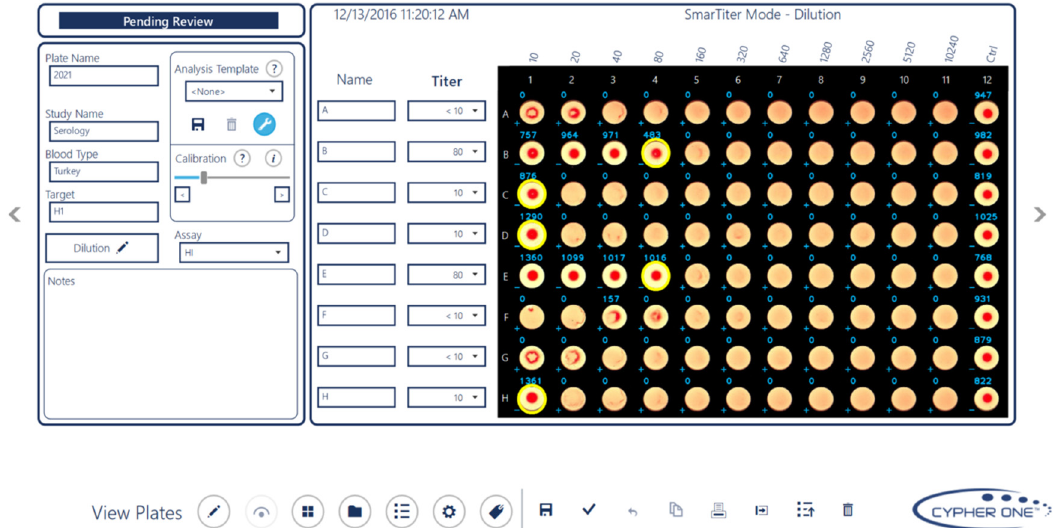
Fig 2. Screen shot of Cypher One user interface. ExampleHAI plate image within a screen shot of the Cypher One software application.High resolutiondigital images were captured and titer values determined using an image analysis algorithmwithin the software. The experimental information, image and resultingtiter values are stored as digital records within the system database.